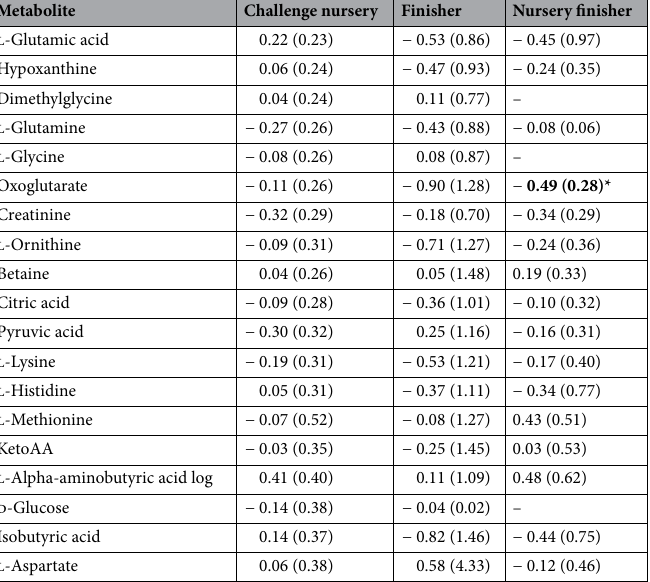
Table 5. Estimates of genetic correlations (SE in parentheses) between the most heritable metabolites and number of treatments in the challenge nursery, finisher, and across the nursery and finisher. Significance of genetic correlations are indicated in bold as: *, corresponding to P ≤ 0.05. “–” indicates not